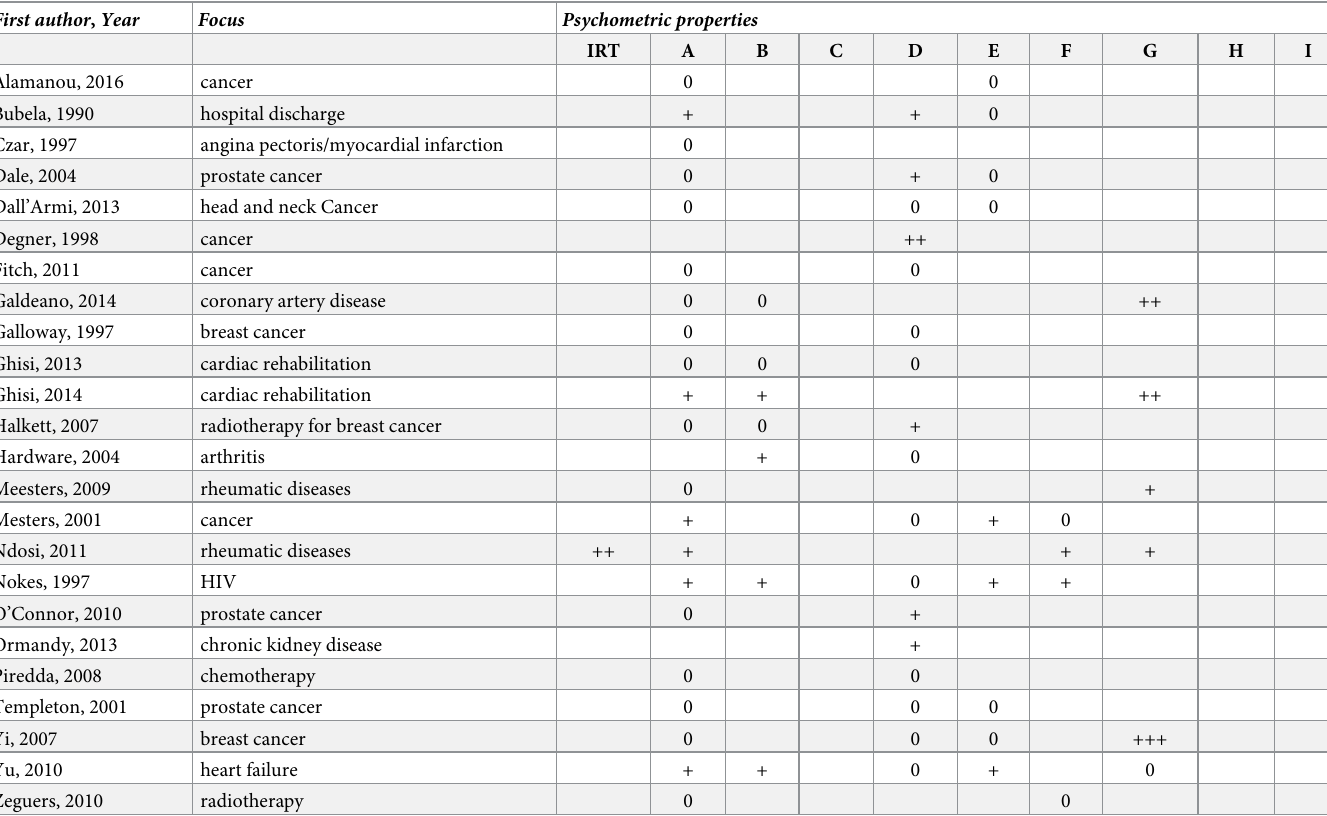
Table 5. Assessment of the methodological quality with COSMIN